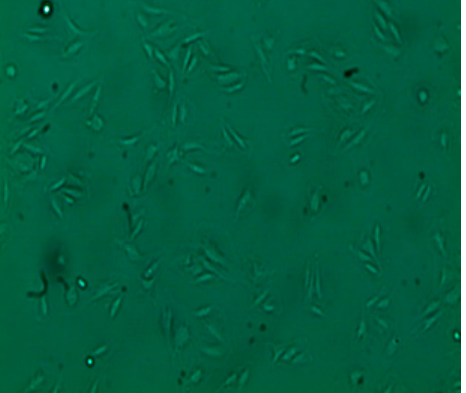
Figure 1. Representative myoblasts derived from passage number 7 myoblasts taken after 1 day seeding into 25 cm 2 (10×).